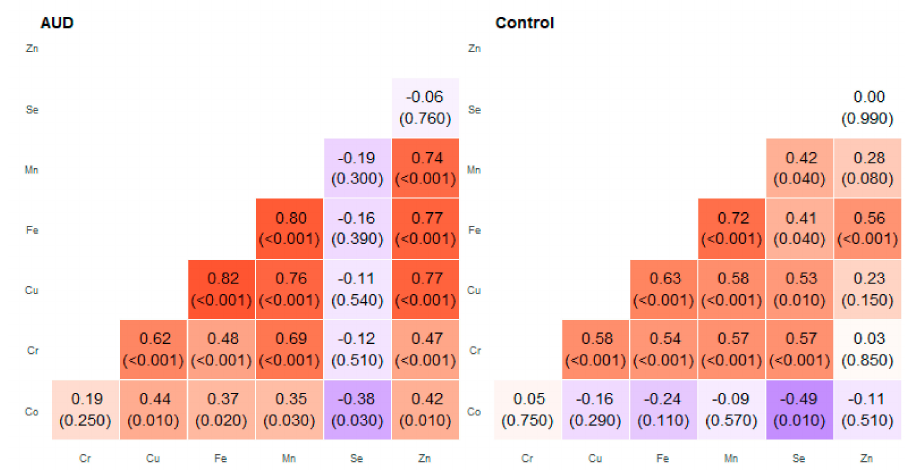
Figure 8. Correlation matrix of Spearman coe ffi cient charts in the nucleus accumbens region in the alcohol use disorder and control groups.